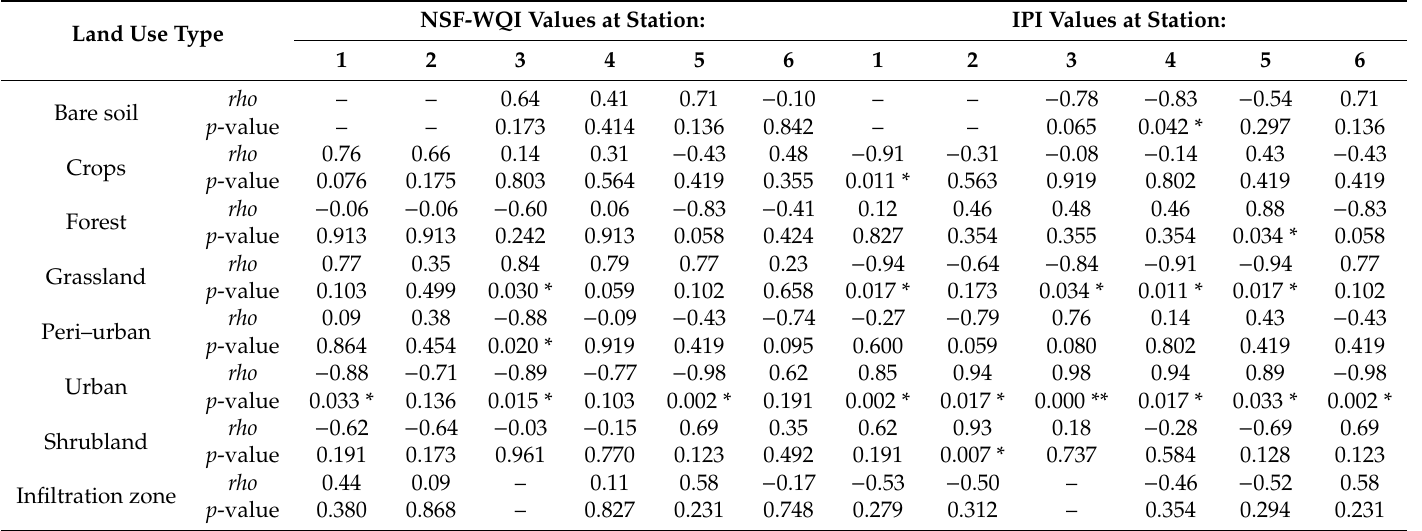
Table 9. Correlation coe ffi cients (Spearman’s rho ) for each of the water quality indices (NSF-WQI and IPI) and the corresponding land use (% of sub-catchment area) for stations 1–6,